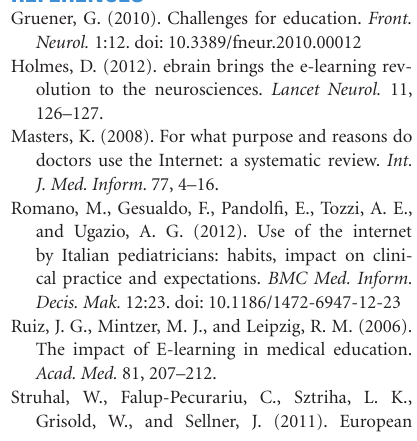
United Kingdom JointNeurosciences Council(UKJNC),the EFNSandtheENS. (C) Usage of different resources for e-learning. (D) Assessment of credibility of internet sources. (E) Awareness of internet websites aimed for